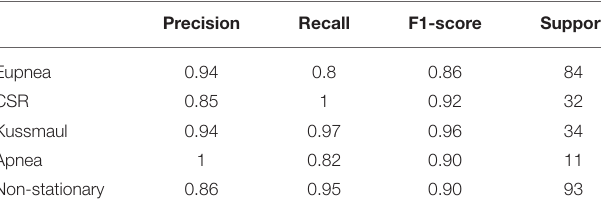
TABLE 3 | Classification report of statistic feature-based model. Precision Recall F1-score